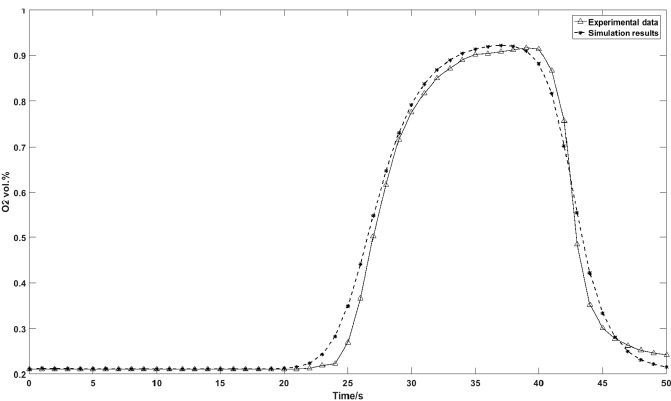
Figure 14. Experimental outflow oxygen concentration with simulation results.